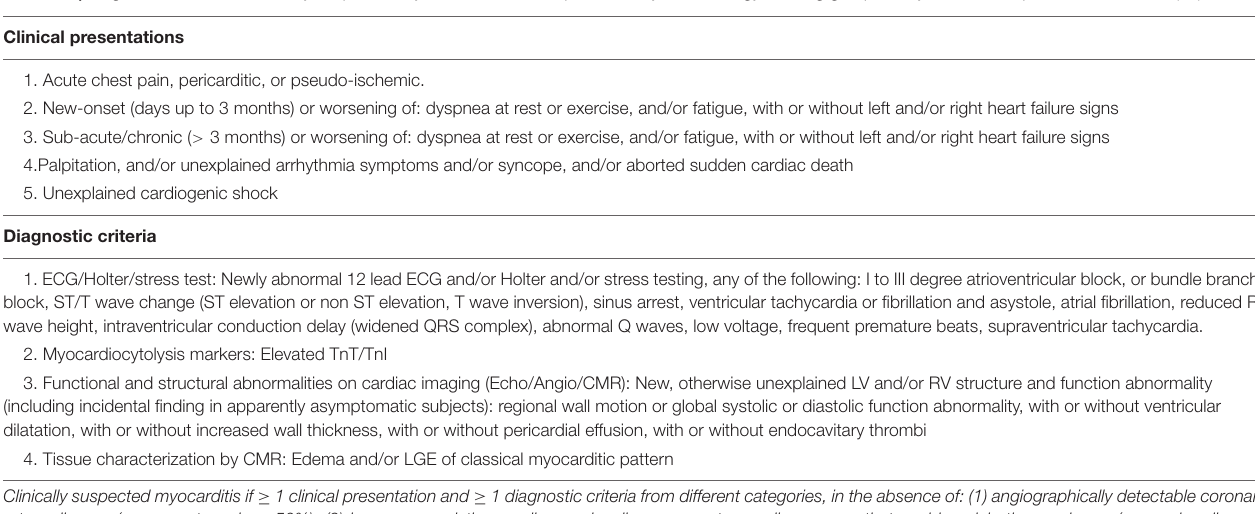
TABLE 1 | Diagnostic criteria for clinically suspected myocarditis from European society of cardiology working group on myocardial and pericardial diseases